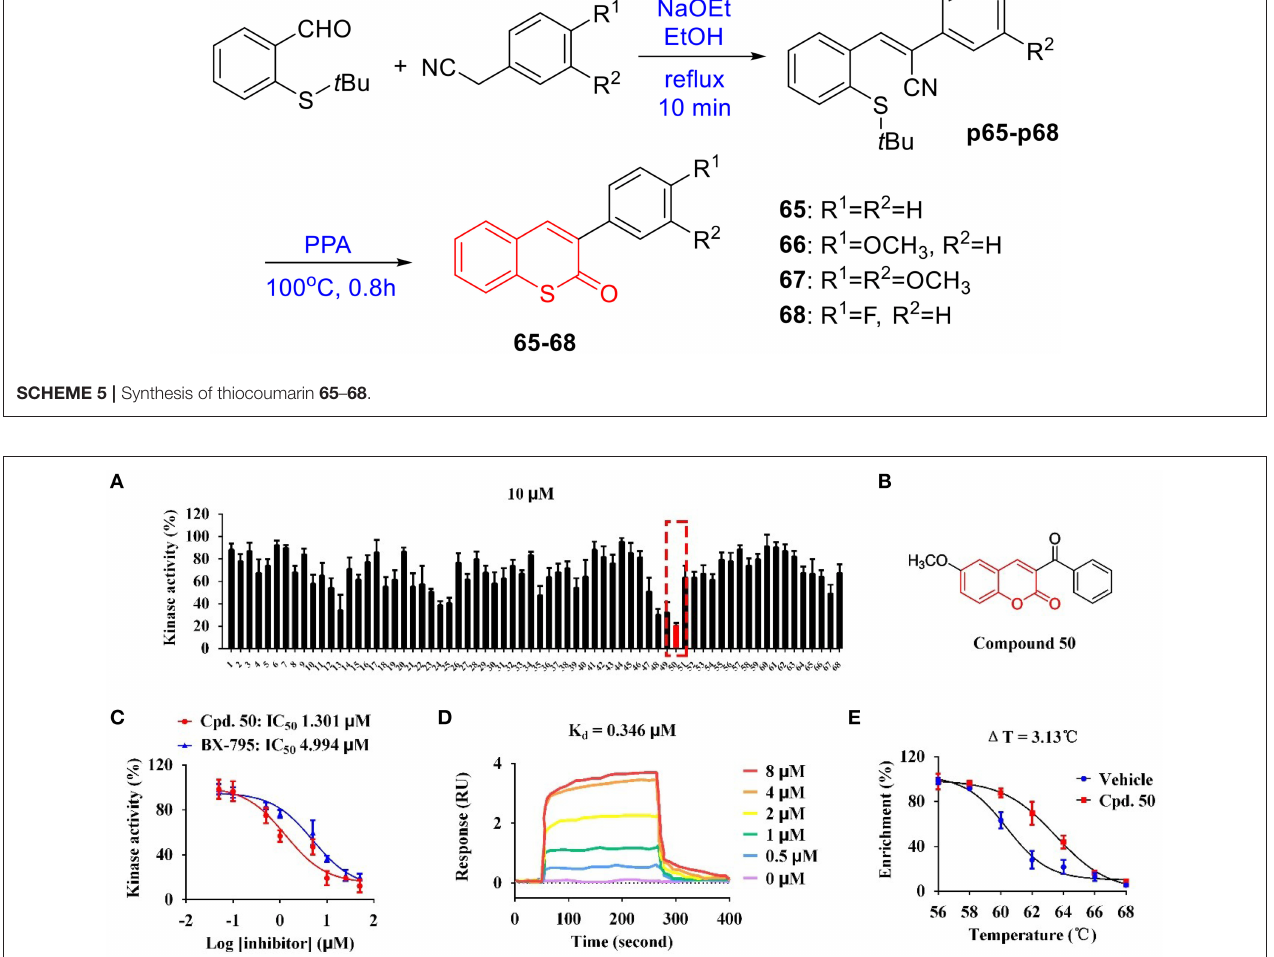
FIGURE 2 | Compound 50 targeted catalytic domain to inhibit MARK4 activity in vitro . (A) Kinase assay of coumarin derivatives at the concentration of 10 µ M using MARK4 as enzyme. (B) Chemical structure of compound 50 . (C) Kinase assay of compound 50 and BX-795 at varied concentrations using MARK4 as enzyme. (D) Surface plasmon resonance (SPR) assay of compound 50 . (E) Thermal shift assay of compound 50